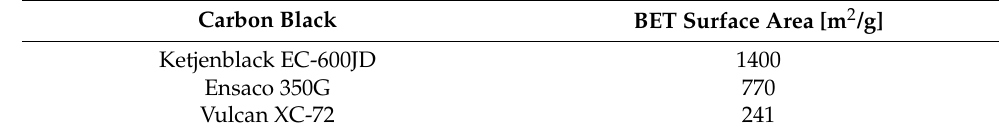
Table 2. BET surface area of the different CBs according to the manufacturer